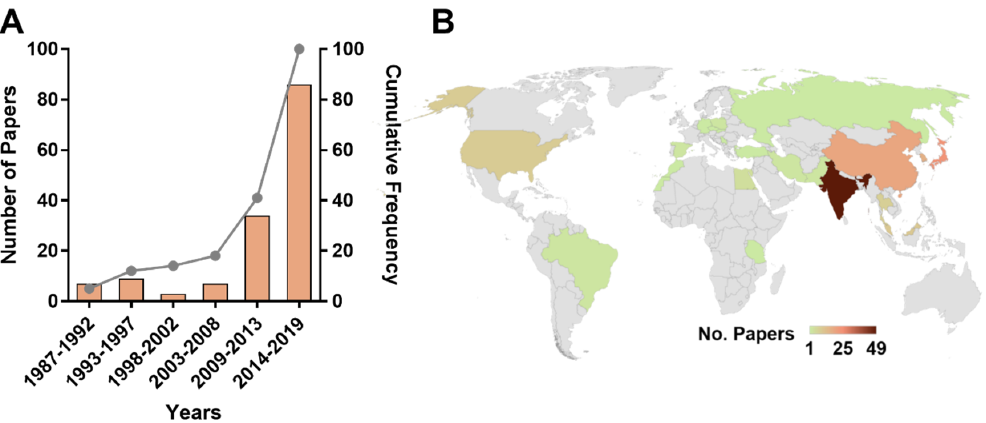
Figure 2. The number of papers in the literature by years and country of origin. ( A ) Publication distribution over the time. The first y -axis shows the number of papers and the second y -axis shows the cumulative frequency distribution. ( B ) World map showing the countries where the articles included in this review were produced, specifically, the corresponding author affiliation. Only in nine articles (6.2%), the sampling place for isolating Streptomyces was different from the country of the corresponding author (See Figure S1).